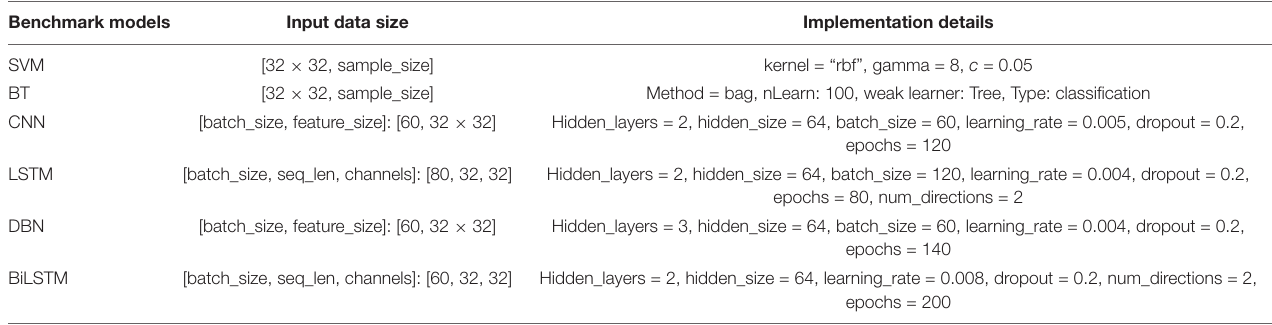
TABLE 2 | Hyper parameters of the benchmark models on PLV feature.